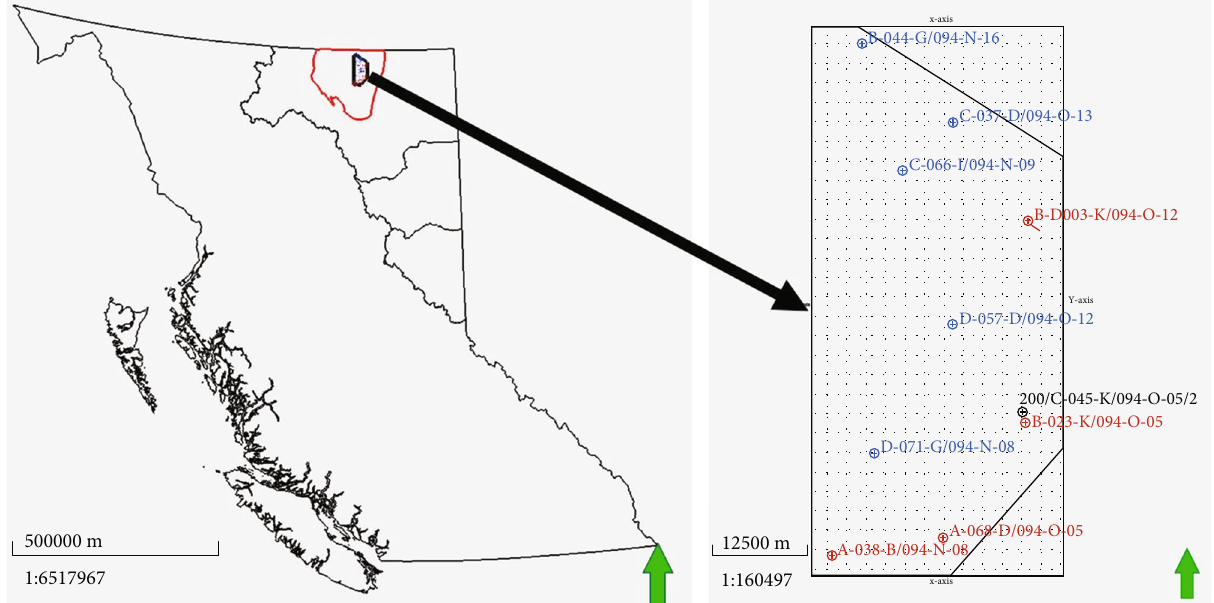
Figure 1: Location of Liard Basin (red line) in British Columbia (left) and location of boreholes in the study area (right). Red color-indicated boreholes have geochemical properties determined by Rock-Eval pyrolysis and well-log data, whereas blue color-indicated boreholes only have well-log data. Black color indicates production well. Table 1: Range of measured parameters by Rock-Eval analysis in the four